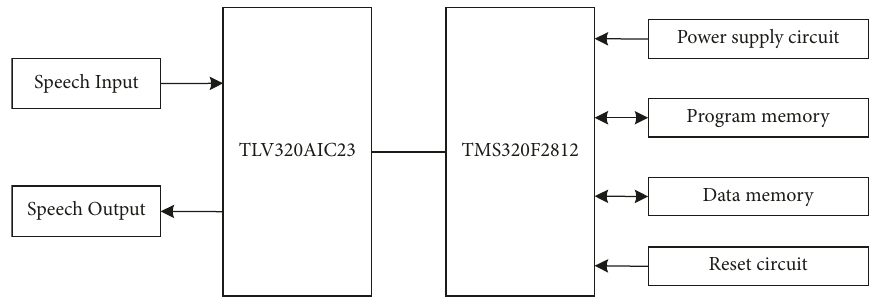
Figure 6: DSP speech enhancement system hardware structure design.